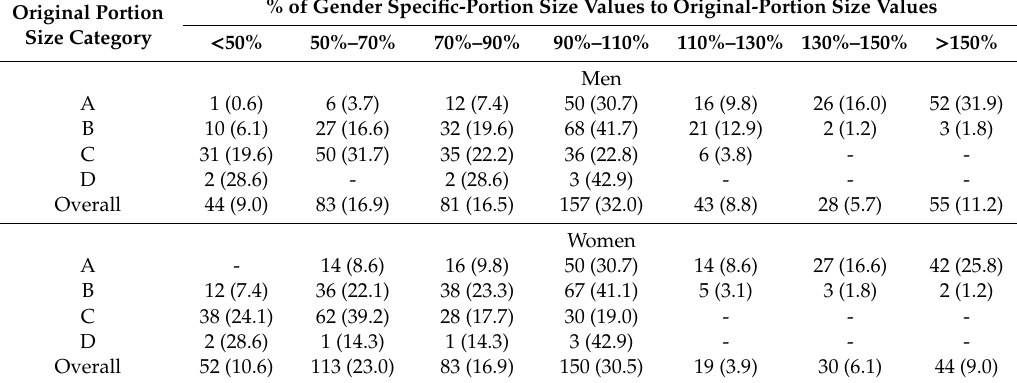
Table 3. Number (%) of food items in each portion size category by the ratio of the values of the newly determined gender specific-portion sizes relative to the values of the original-portion sizes (expressed as a percentage) of the Multiethnic Cohort quantitative food frequency questionnaire 1